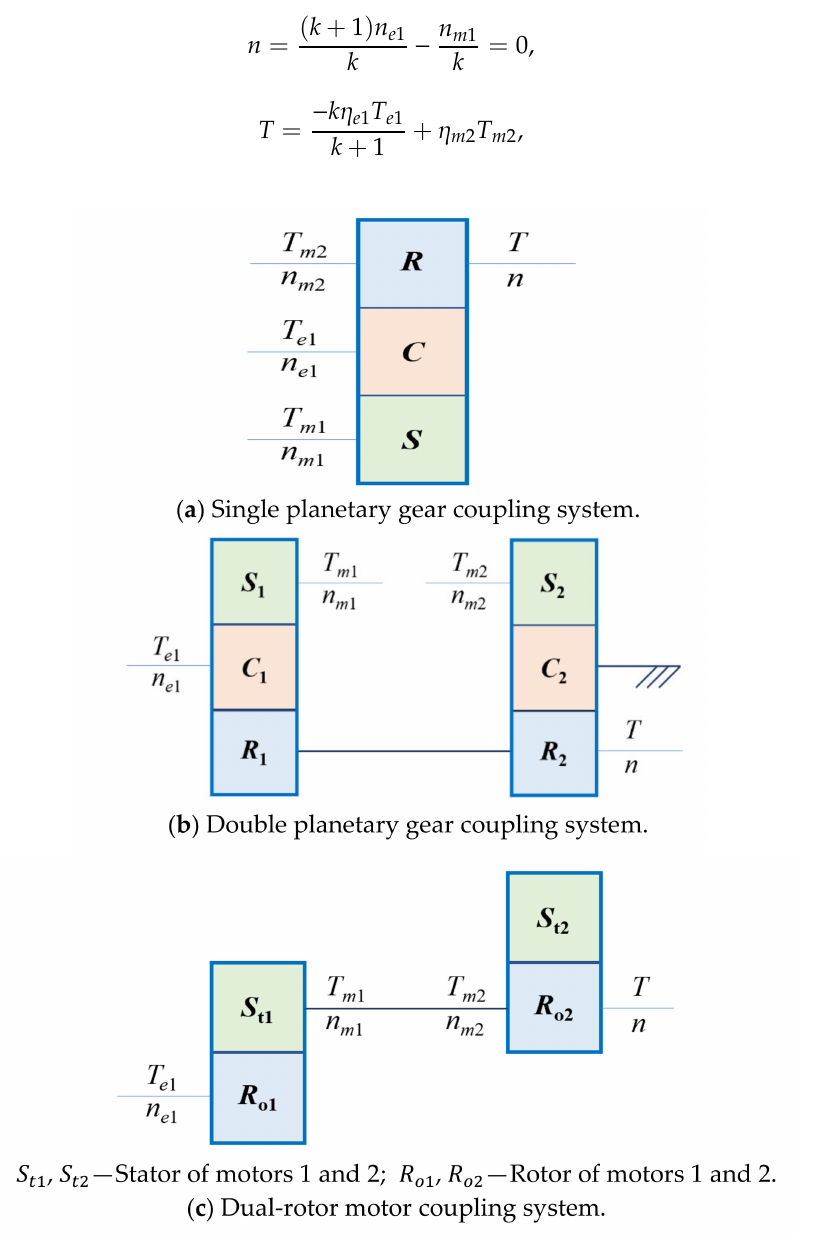
Figure 8. Schematic diagram of hybrid coupling